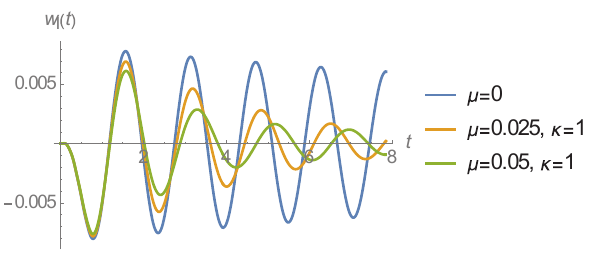
the orange line is for an absorber with parameters μ =0.05, κ =1 and the green line is for μ =0.025, κ =1.